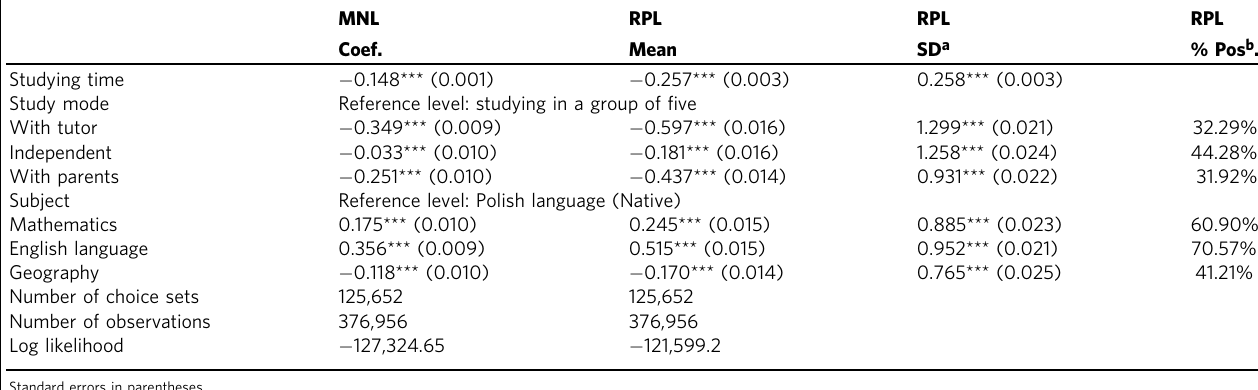
Table 1 Estimated coef fi cients for multinomial logistic regression and random parameter logistic regression.